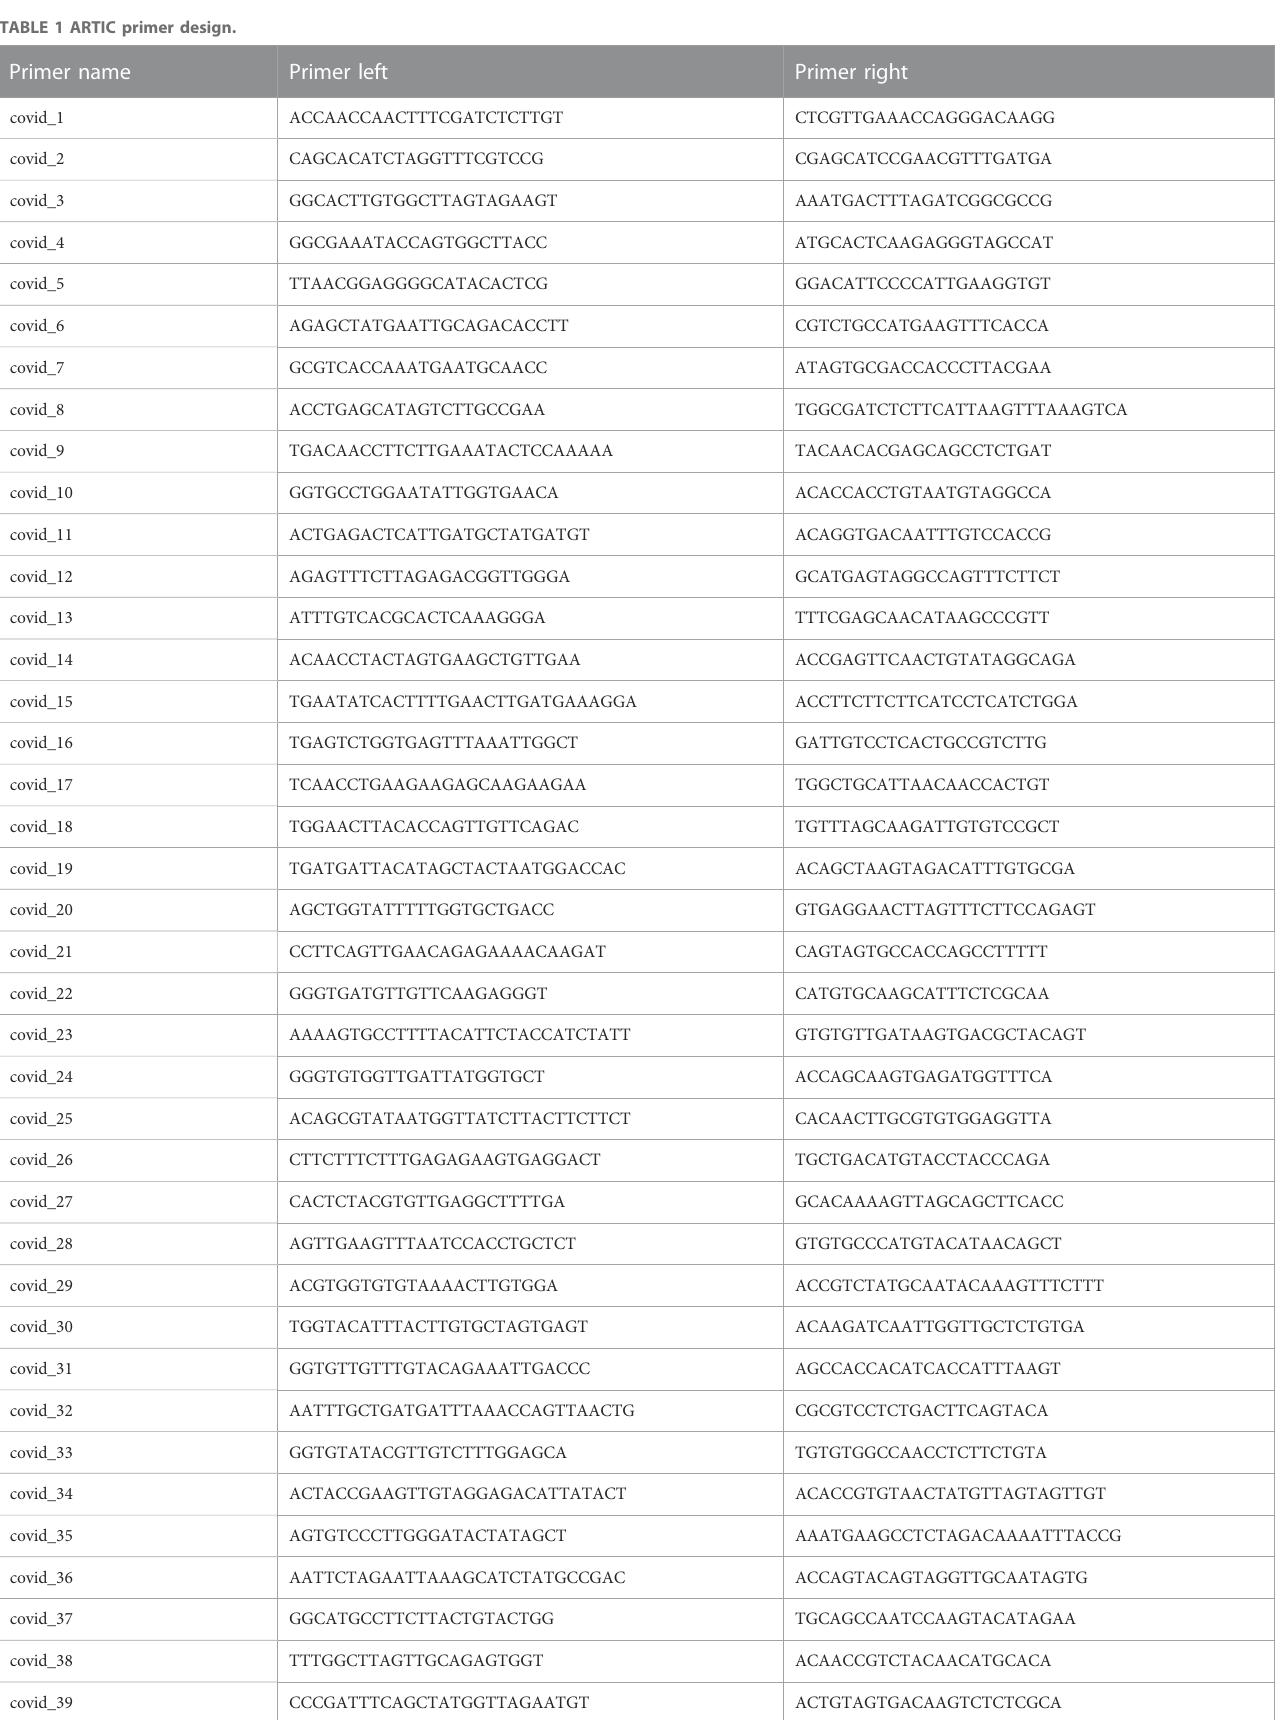
TABLE 1 ARTIC primer